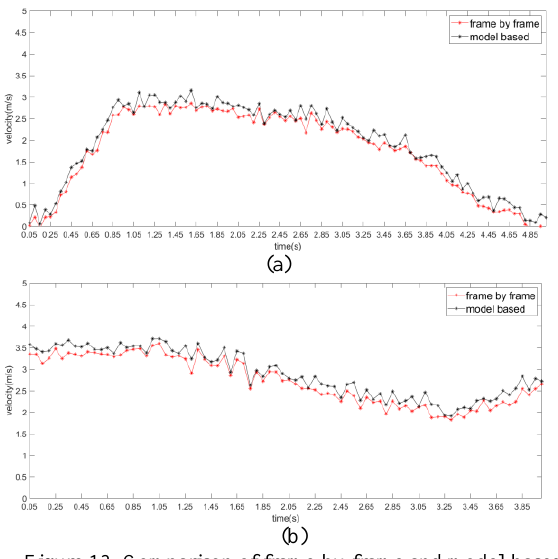
Figure 13. Comparison of frame-by-frame and model-based tracking